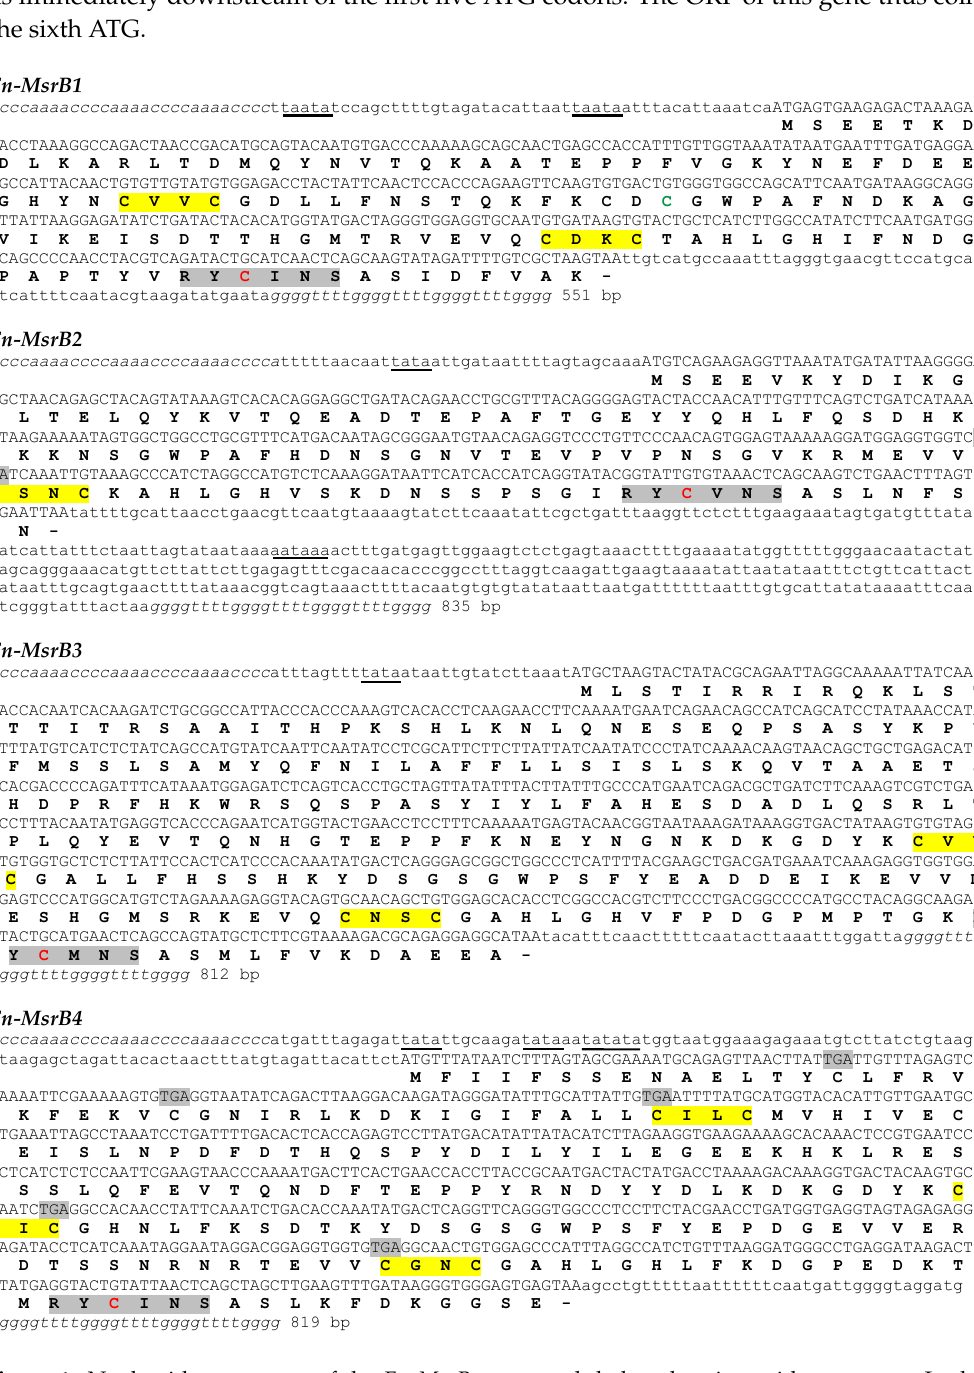
Figure 1. Nucleotide sequences of the En-MsrB genes and deduced amino acid sequences. In the nucleotide sequences, the telomeric repeats are in italics, the 5’ leader and 3’ trailer regions in lower case letters and the open reading frame in capital letters. The putative transcriptional regulation and polyadenylation signals are underlined, and the in-frame TGA codons highlighted in grey. In the amino acid sequences, the CXXC motifs and the catalytic sites are highlighted in yellow and grey, respectively, and the catalytic and the resolving cysteines are highlighted in red and green, respectively.